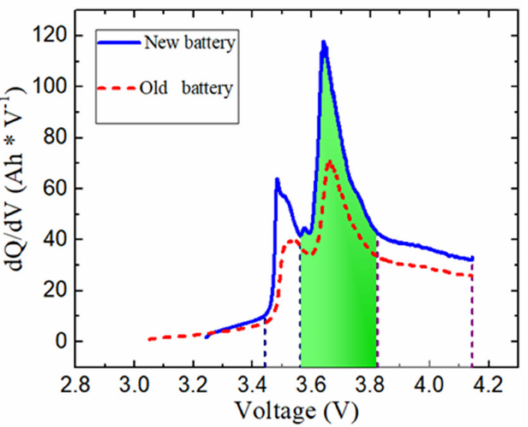
Figure 2. Difference of main peak area of IC curve between new and old